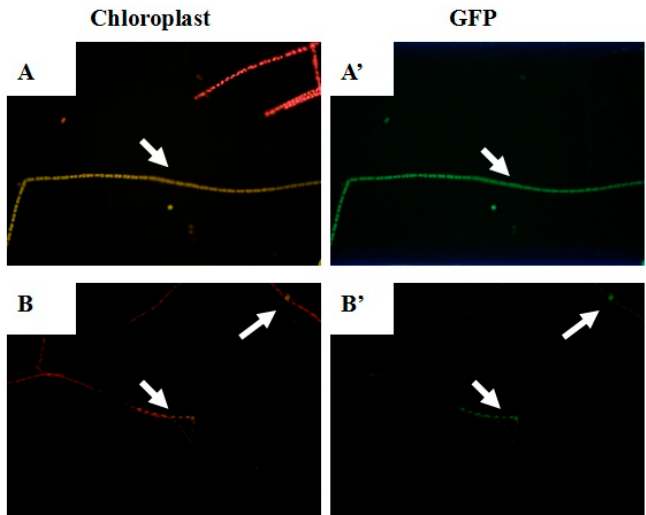
Figure 4. Phenotypic characterization of pSimple- tub-eGFP transformed T. minus under 450 psi. Detection was in the range of 685–735 nm for chloroplast autofluorescence ( A , B ) and 495–556 nm for eGFP ( A’ , B’ ).